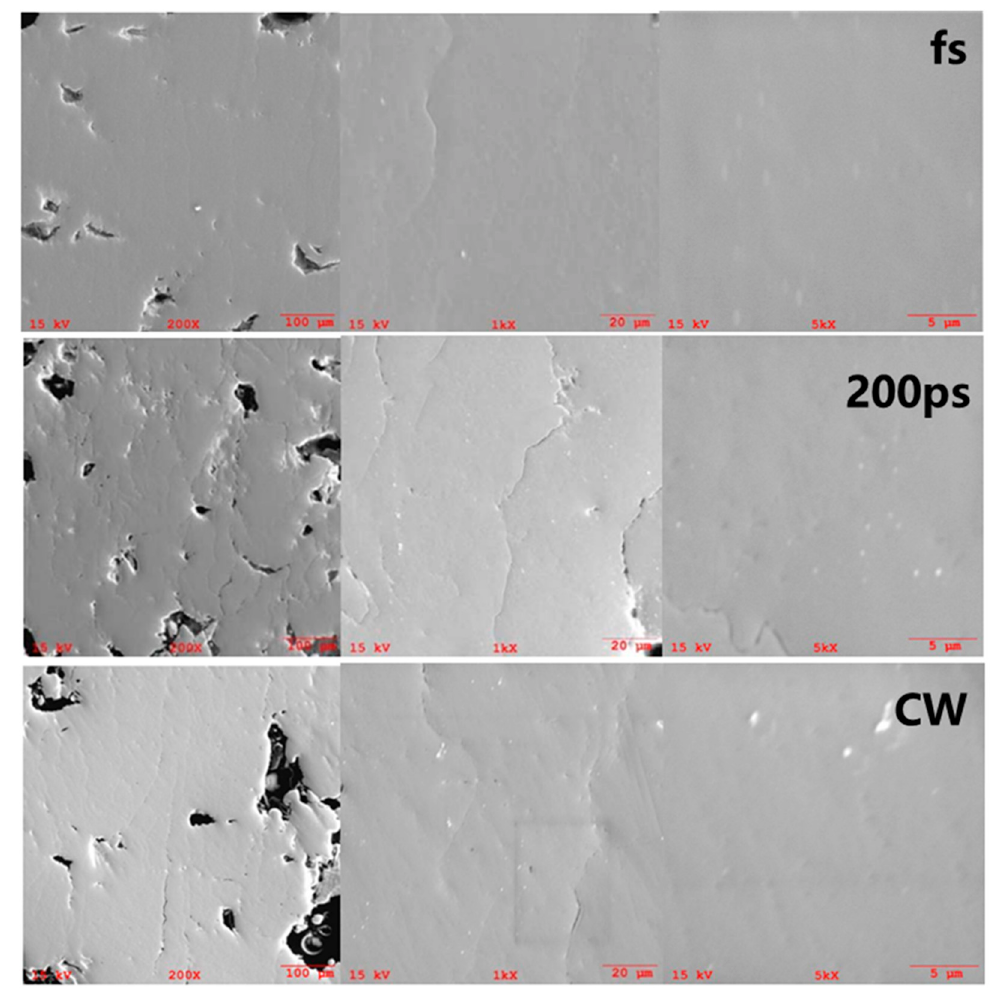
Figure 3. Cross section of tungsten sample, from top to bottom, made by fs,200 ps and CW; from left to right, SEM image of ×200, ×1000, ×5000 [56]. Table 1. Summary of the hardness testing results for different samples [56].